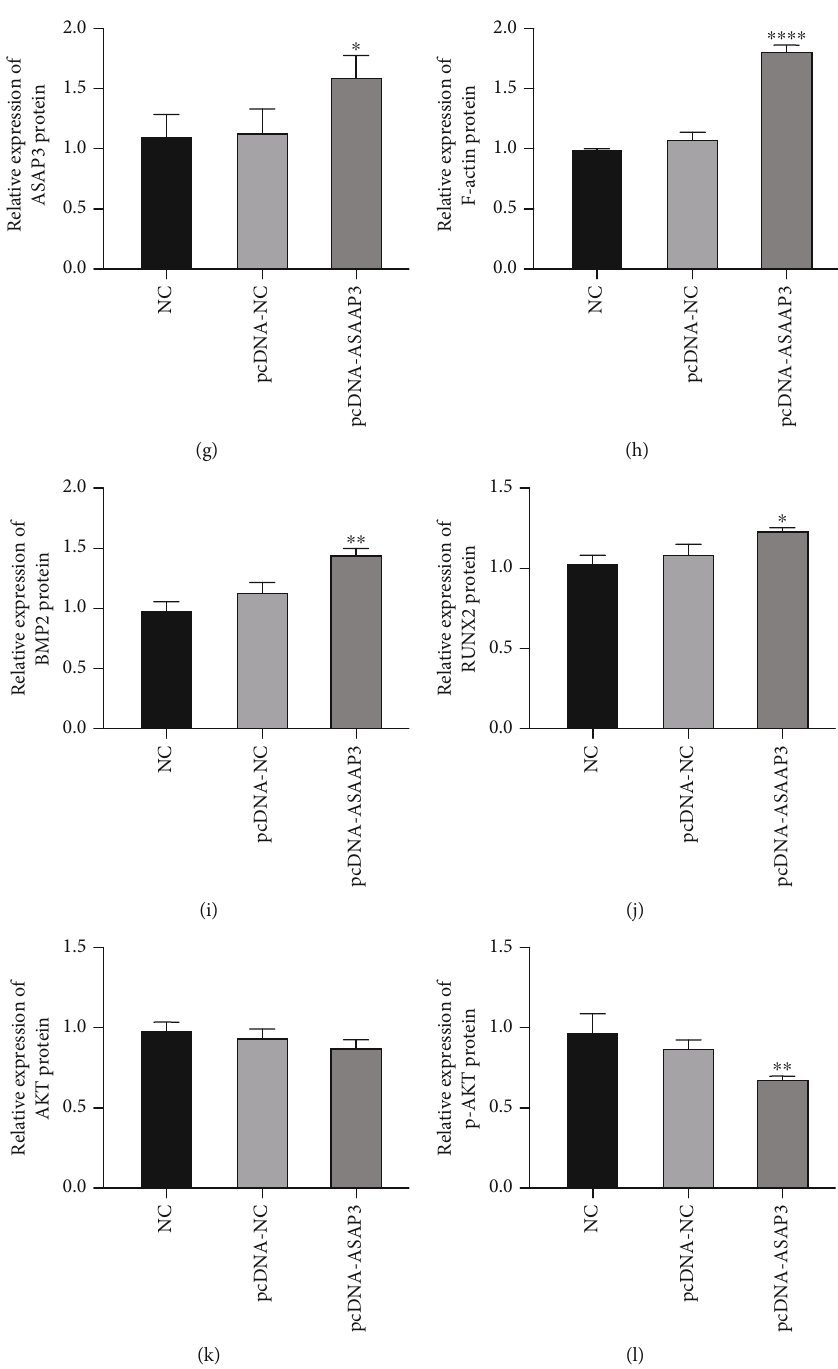
Figure 5: Regulation of cytoskeleton and osteogenesis of MG63 cells by ASAP3. (a) RT-qPCR detected the mRNA expression of ASAP3. (b, c) Western blot detected the levels of ASAP3 protein. (d, e) F-actin fl uorescence intensity was detected by rhodamine-labeled phalloidin staining. Compared with the si-NC group, ∗ P < 0 : 05 , ∗∗∗ P < 0 : 001 . (f) Western blot detected the protein levels of ASAP3 (g), F-actin (h), BMP2 (i), RUNX2 (j), AKT (k), and p-AKT (l). Compared with the pcDNA-NC group, ∗ P < 0 : 05 , ∗∗ P < 0 : 01 , and ∗∗∗∗ P < 0 : 0001 ; ns: no signi fi cant di ff